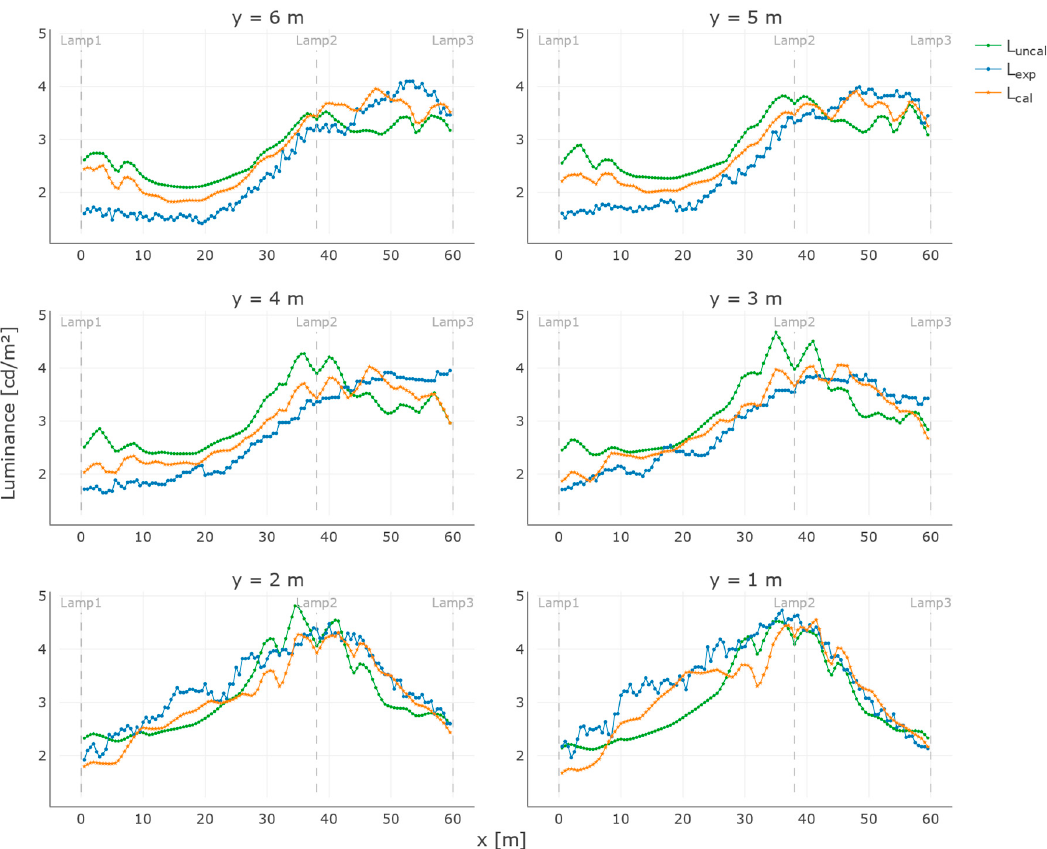
Figure 12. Luminance in longitudinal sections of the road. L exp : luminance collected experimentally; L uncal : simulated luminance using the r-table established by default for a R1 road surface after calibration of the Q 0 factor; and L cal : simulated luminance after the calibration of the reduced luminance coe ffi cients of the r-table. Table 8. CV(RMSE) and RMSE calculated for the initial simulation and the simulation of the calibrated